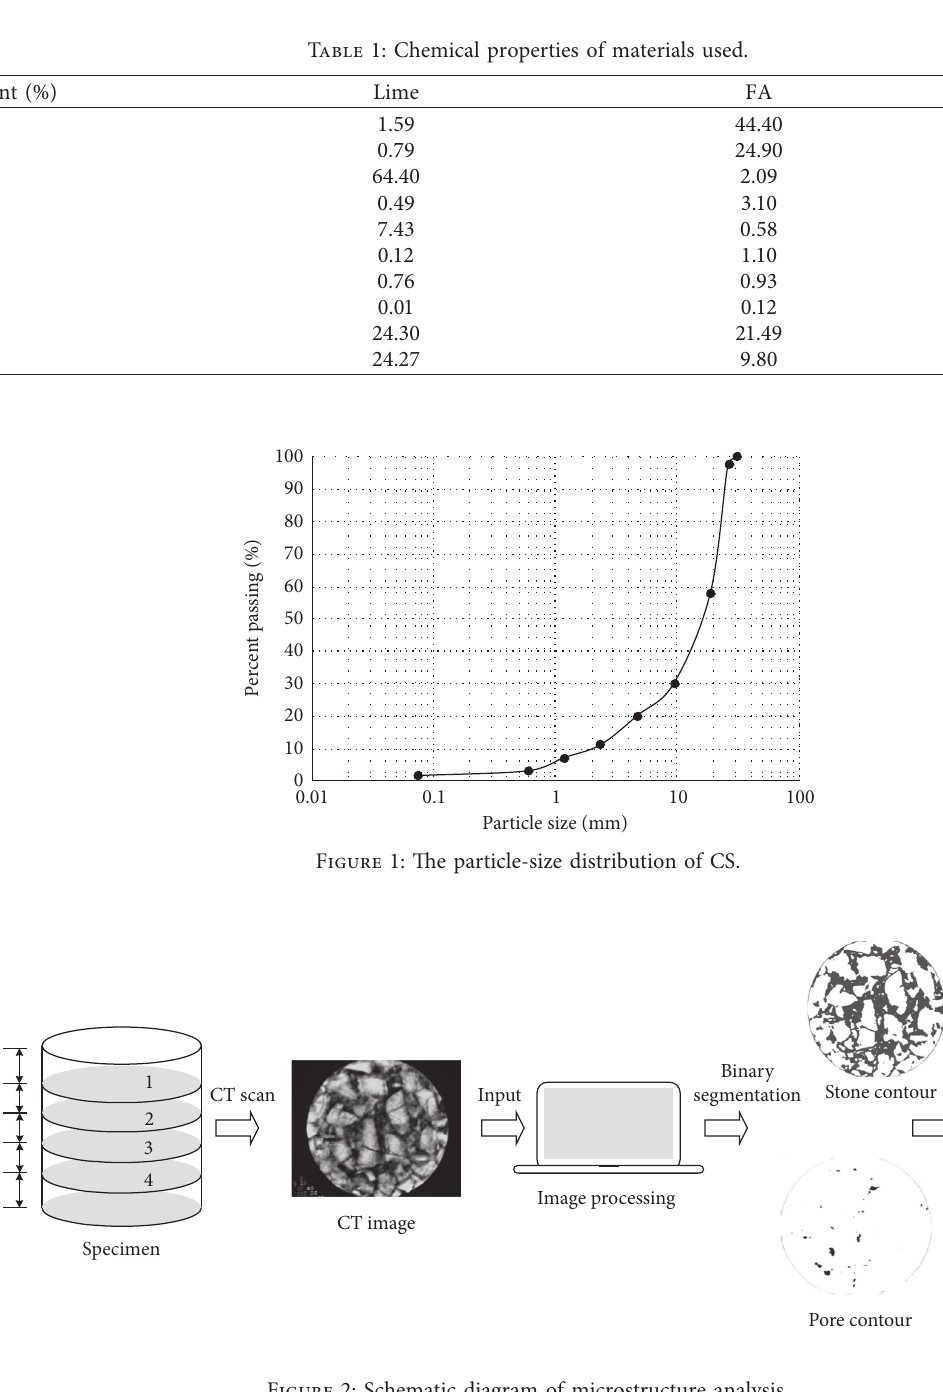
Figure 2: Schematic diagram of microstructure analysis.